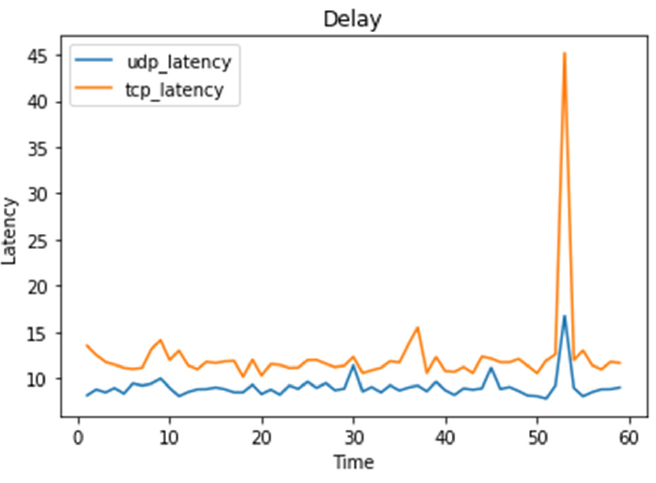
Figure 14. Path Delay